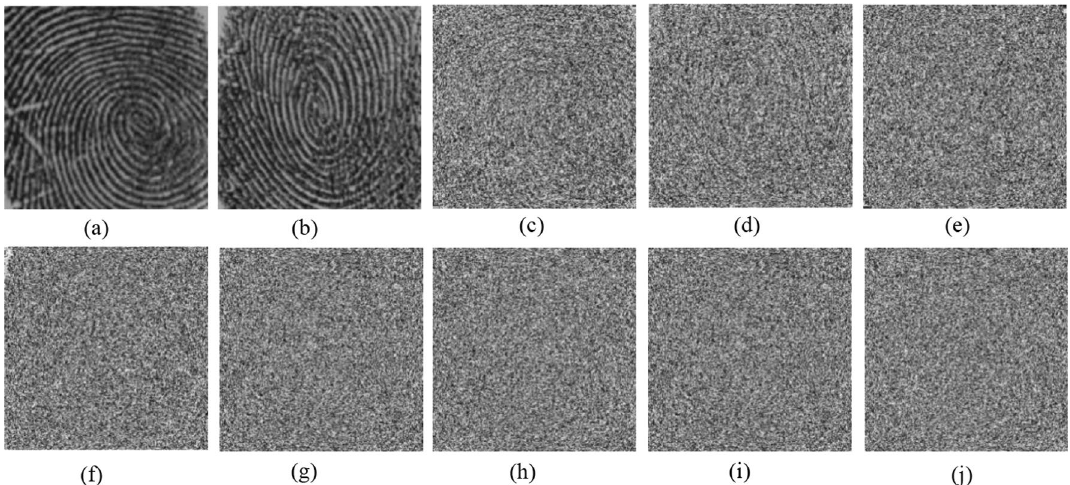
Figure 4. All keys in the experiment ( a ) Alice’s private key k a ; ( b ) Bob’s private key k b ; ( c , d ) are two parts of Alice’s public key K A = ( K Ax , K Ay ) , respectively; ( e , f ) are two parts of Bob’s public key K B = ( K Bx , K By ) , respectively; ( g , h ) are ( p 1 , p 2 ) , generated by k a ⊗ K B in Alice’s encryption; ( i , j ) are ( p 1 , p 2 ) , generated by k b ⊗ K A in Bob’s decryption.